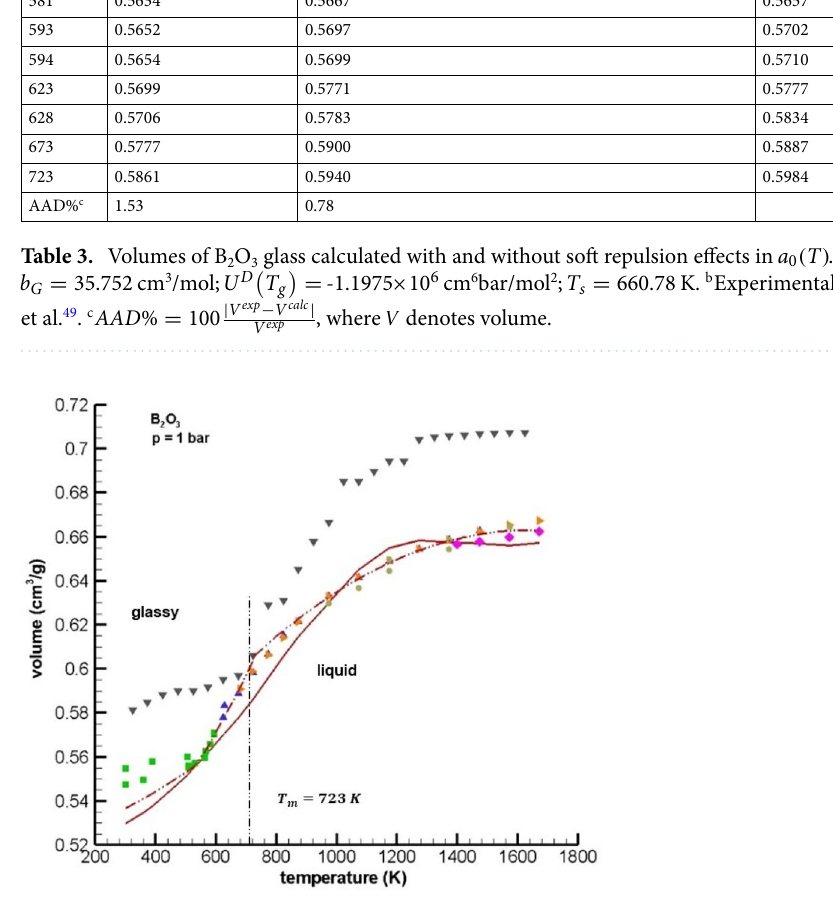
Figure 3. Specific volume vs. temperature for glassy B 2 O 3 and B 2 O 3 melt at 1 bar. experimental data: Macedo and Litovitz 10 ( ), Napolitano et al. 48 ( ), Macedo et al. 49 ( ), Roebling 50 ( ), Chebykin et al. 51 ( ). Simulations: MD Huang and Kieffer 4 ( ), multiscale GHC equation without soft repulsion ( ), moving boundary equation with soft repulsion/temperature-dependent boroxol ring structure (